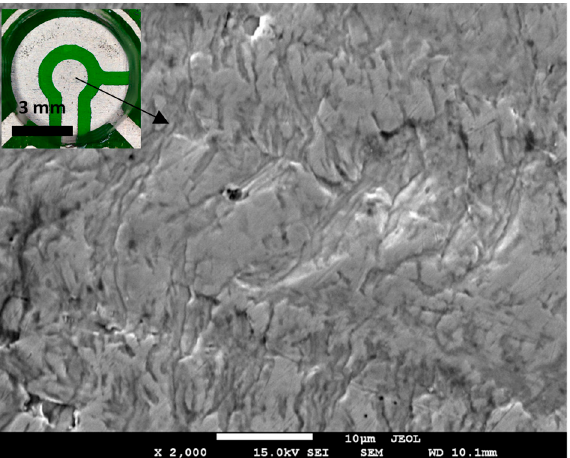
Figure 6. SEM micrograph of rolled-annealed Cu electrode surface. Inset shows a fabricated